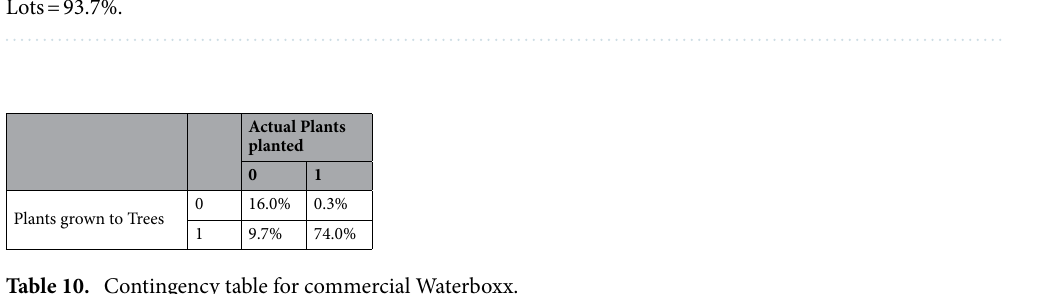
Table 10. Contingency table for commercial